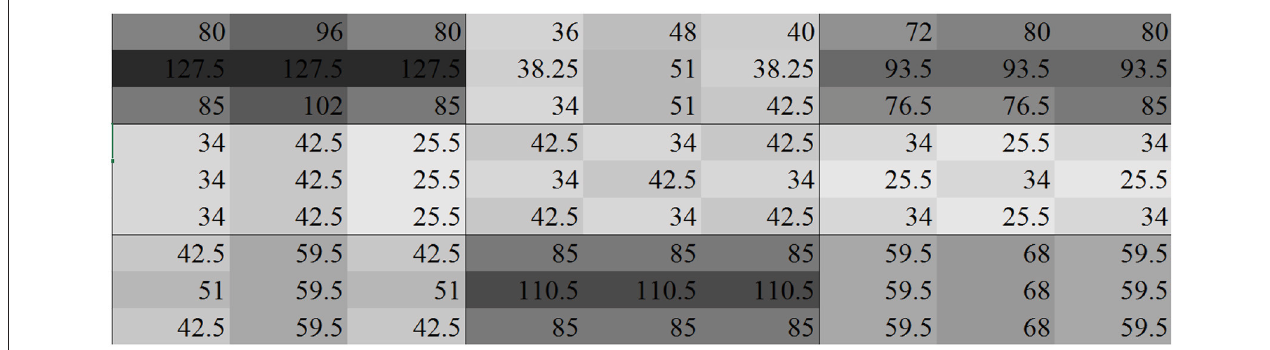
FIGURE 10 | Distribution of illuminance based on maximized coverage levels around the zones, with greater influence of light installation cost on solution produced, Point